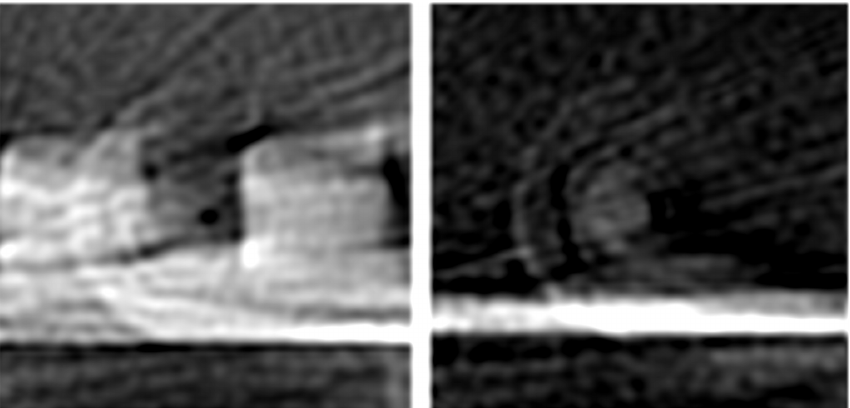
Figure 6. Left : The Two Squares model scan overlapped with an artifact; Right : This artifact can be more clearly seen when the platform is empty.